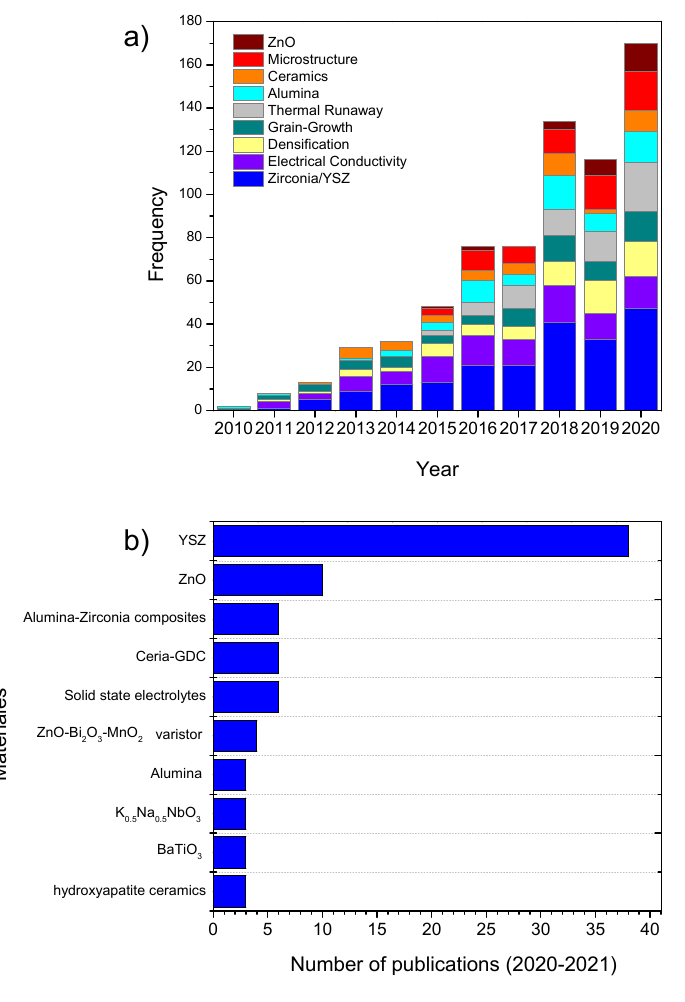
Figure 4. ( a ) Keywords Plus dynamic and ( b ) top 10 studied materials during the two-year period